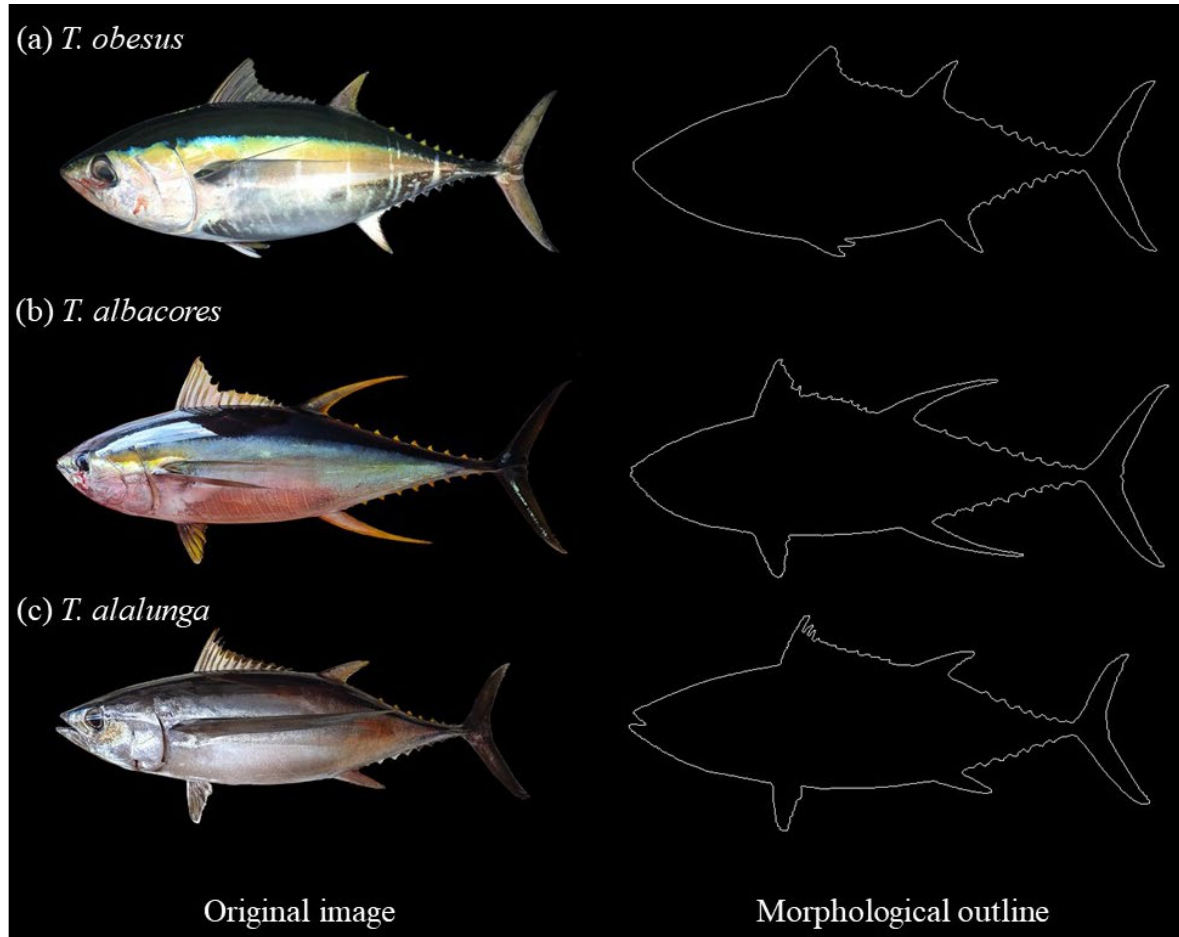
Figure 1. Three Thunnus species: the original image is on the left and the morphological outline is on the right.